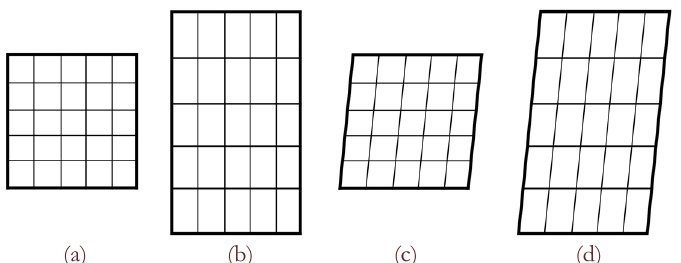
Figure 3: Illustration of different deformation patterns from different loading types. a) Without applied loads, b) axial loading, c) shear loading, and d) biaxial